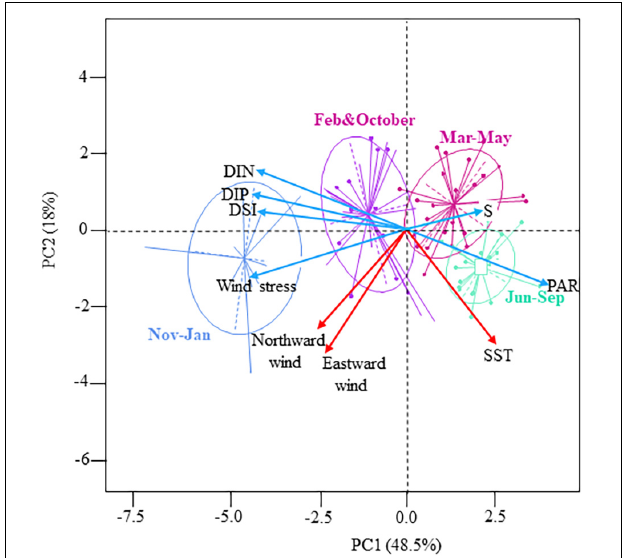
FIGURE 1 | Principal Component Analysis showing the seasonal variations of the abiotic environment in coastal waters of the eastern English Channel over the period 2007–2013. Projection of the variables and of the observations (from January to December) on the factorial map (Eigenvalues are given into brackets, 66.5% of the total inertia). Blue and red arrows: significant Pearson correlation with the first (PC1) and second (PC2) principal components. Blue, purple, pink and green ellipses: Hierarchical Agglomerative Clustering (HAC) of the observations on the factorial map using the Ward’s linkage. Photosynthetic Active Radiation (PAR m − 2 d − 1 ), Salinity (S, n.u), Sea Surface Temperature (SST, ◦ C), Dissolved Inorganic Nitrogen (DIN, µ M), Phosphorus (DIP, µ M), Silica (DSi, µ M), Northward and Eastward winds (m s − 1